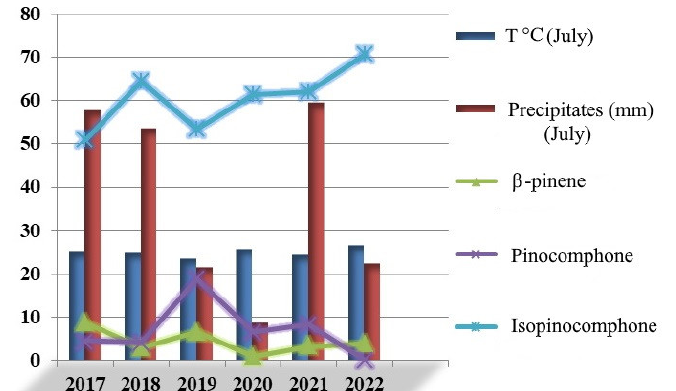
Figure 3. Relationship between some climate dimensions and main essential oil component amounts.